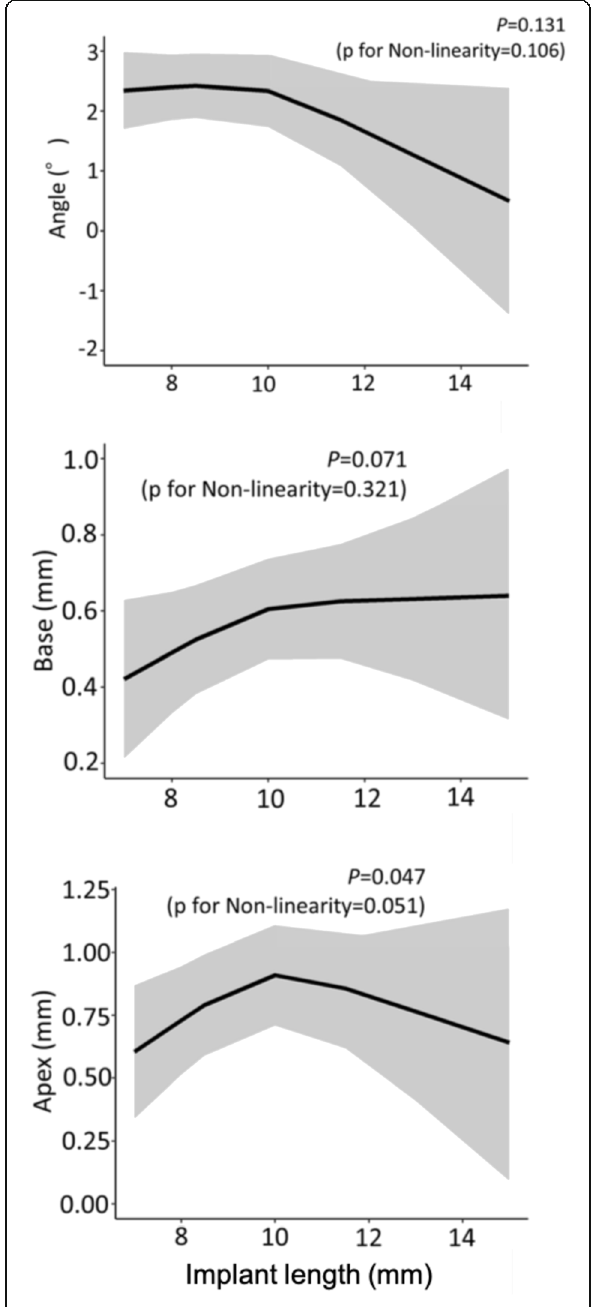
Fig. 10 The errors caused by differences in the implant length. The shaded area shows 95% confidence intervals